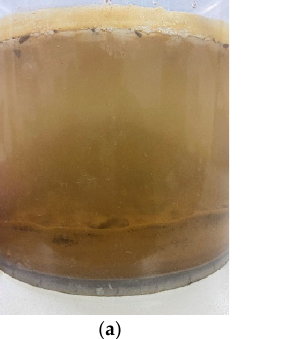
Figure 6. State of the sample after curing for 6 days and immersion for 5 h. ( a ) Glacial till without F1; ( b ) stabilized soil doped with F1 at a concentration of 0.35 L/m 3 .